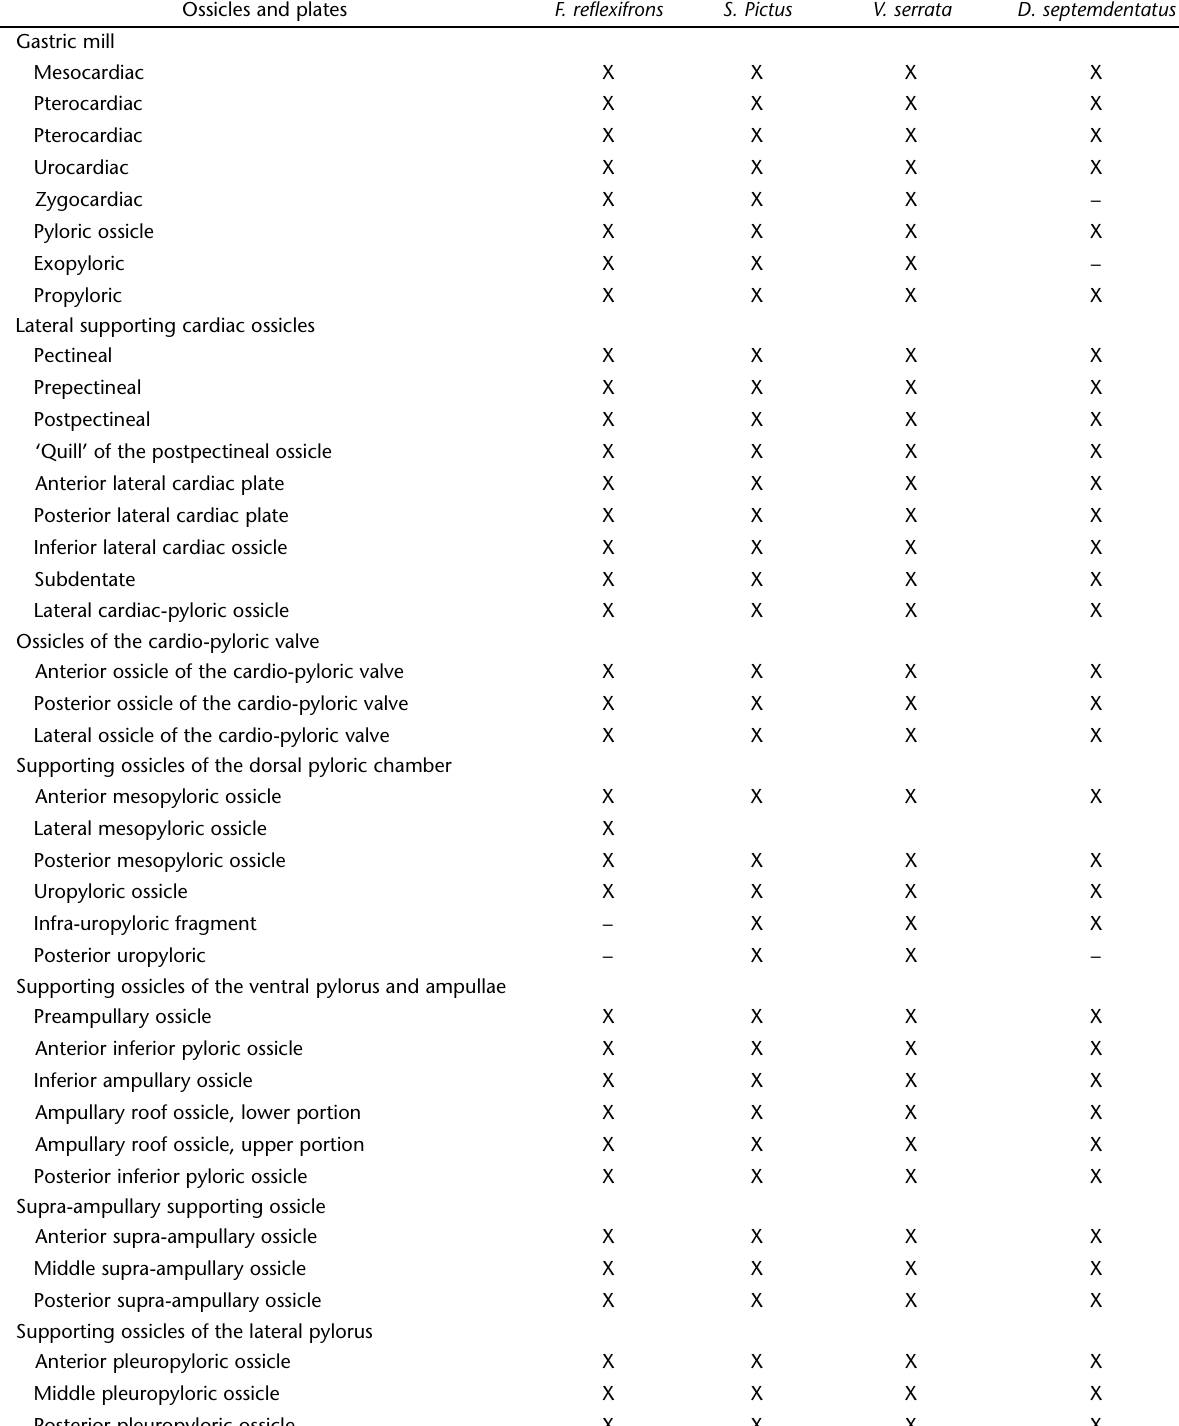
Table I. Ossicles found in the foregut of the freshwater crabs F. reflexifrons , S. pictus , V. serrata and D. septemdentatus . Ossicles and plates